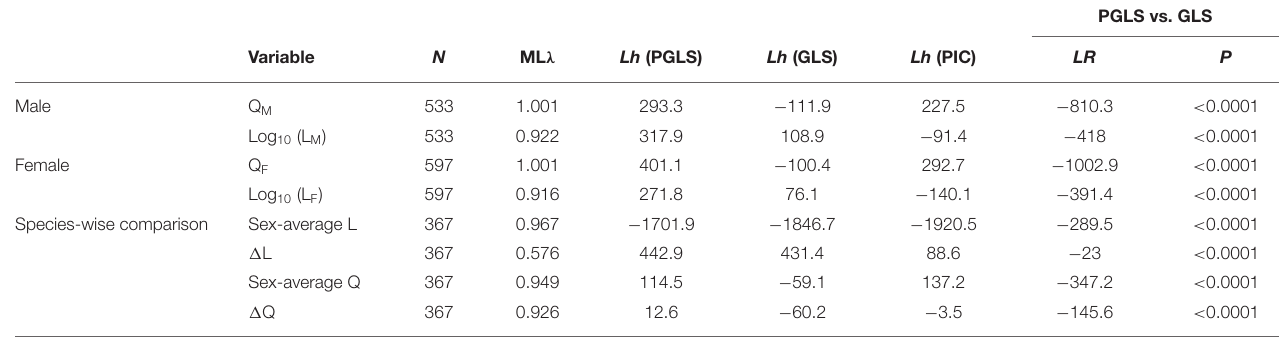
TABLE 2 | Summary of statistical results for best model fits, comparing phylogenetic generalized least squares (PGLS) models ( λ estimated by maximum likelihood, ML) with generalized least square (GLS) models ( λ = 0) for log-transformed body length (i.e., log 10 L) and relative wing size ( Q ).